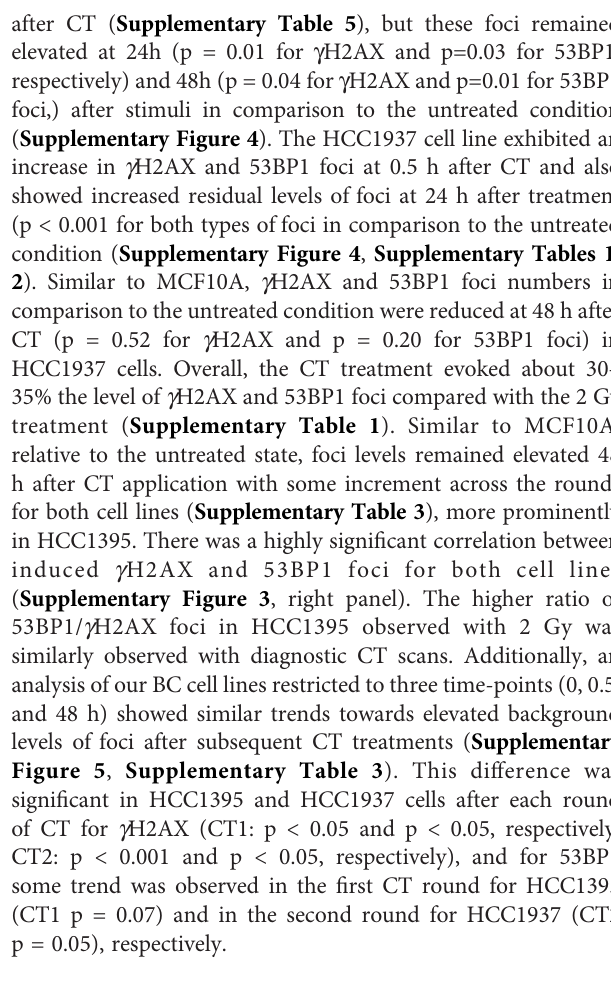
FIGURE 1 | Immunocytochemical analysis of repair foci after single dose in MCF10A cells. Evaluation of g H2AX foci (left) or 53BP1 foci (right) after irradiation with either 20 mGy (CT) or 2 Gy, respectively; using conventional fl uorescence microscopy (Leica DMI6000B). Data are presented as bar plots with the average foci number (+/ − SEM) per cell per experiment from at least three independent experiments (UNT, untreated values with included “ age-matched ” controls; p values on graph represent comparison to UNT; ns, not signi fi cant; SEM, standard error of the mean). ***P ≤ 0.001,